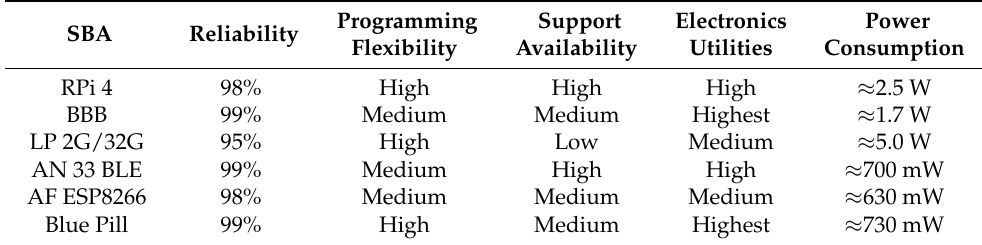
Table 10. Results obtained in the experimental framework with SBAs: Raspberry Pi 4 B (RPi